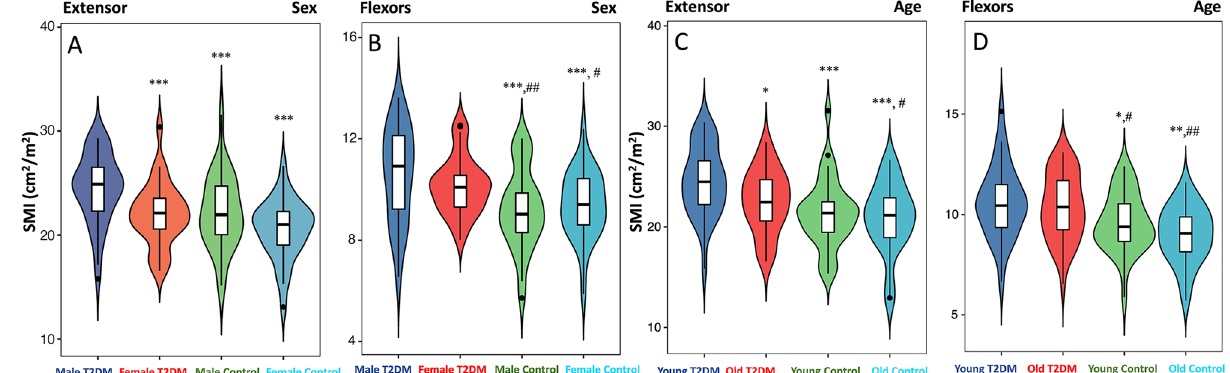
Figure 3. Difference in SMI regarding sex and age. ( A ) Male and female extensors SMI in T2DM patients and control group; ( B ) Male and female flexors SMI in T2DM patients and control group; ( C ) Young and old extensors SMI in T2DM patients and control group; ( D ) Young and old flexors SMI in T2DM patients and control group; * p < 0.05, ** p < 0.01, *** p < 0.001, vs. Male/Young T2DM patients. # p < 0.05, ## p < 0.01, vs. Female/ Old T2DM